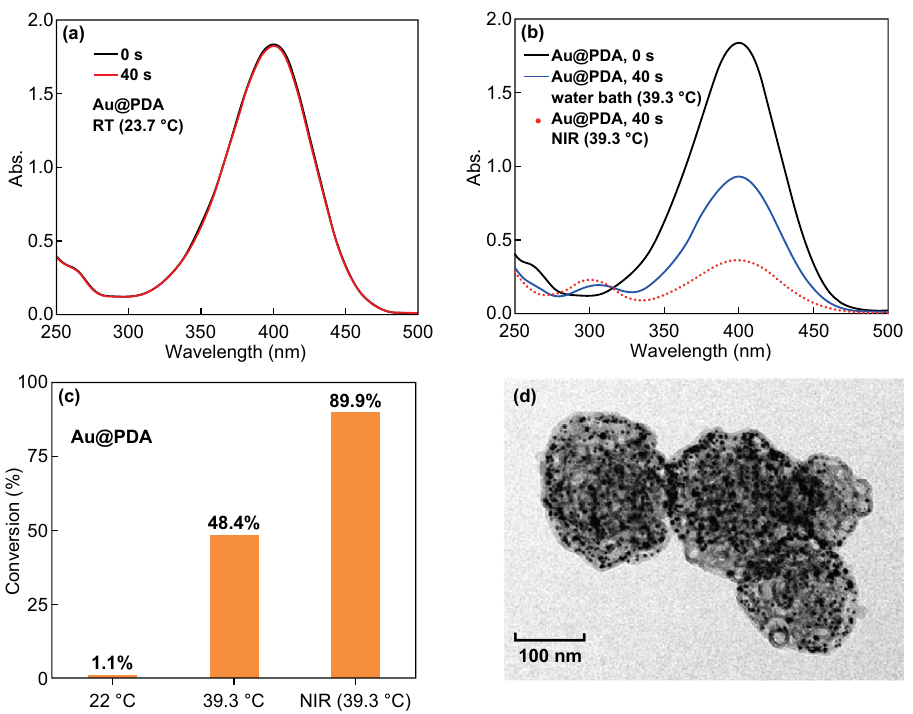
Fig. 8 UV ‑Vis spectra of the reduction of 4‑nitrophenol using Au@PDA particles as nanoreactors a without NIR irradiation at RT, b without NIR irradiation at 39.3 °C and under NIR irradiation at 3 W cm −2 for 15 min. c Conversions of the three reactions. d TEM image of Au@PDA particles after used in catalytic reactions under NIR irradiation. (Color figure